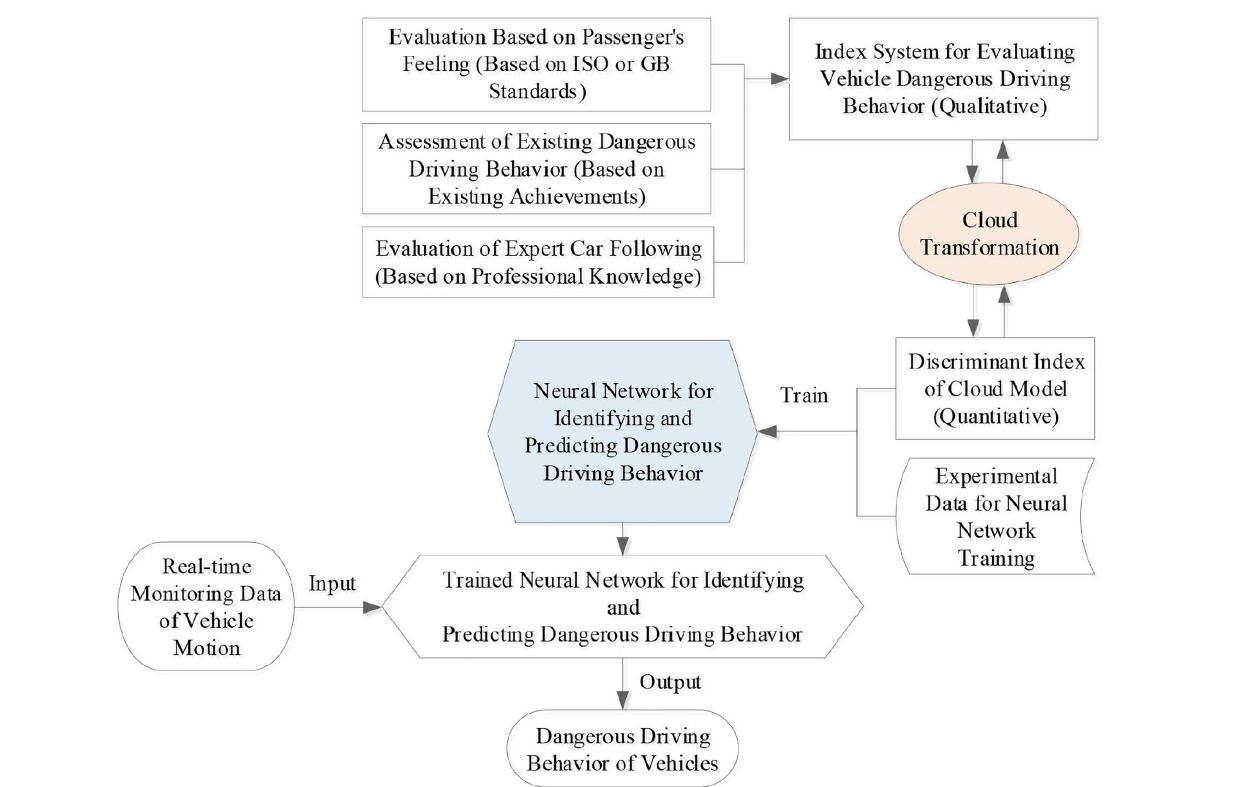
FIGURE 1 | The overall framework of cloud model and Elman neural network (CM-ENN) model for dangerous driving behavior prediction.